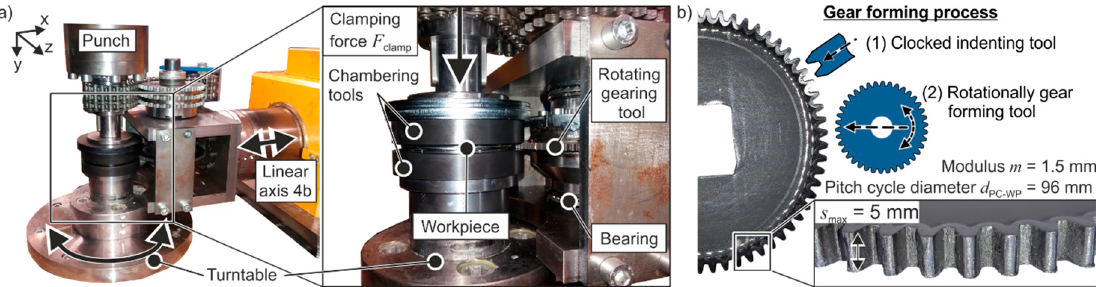
Figure 7. ( a ) Setup of rotating gear forming. ( b ) Clocked indenting and rotating process strategies for